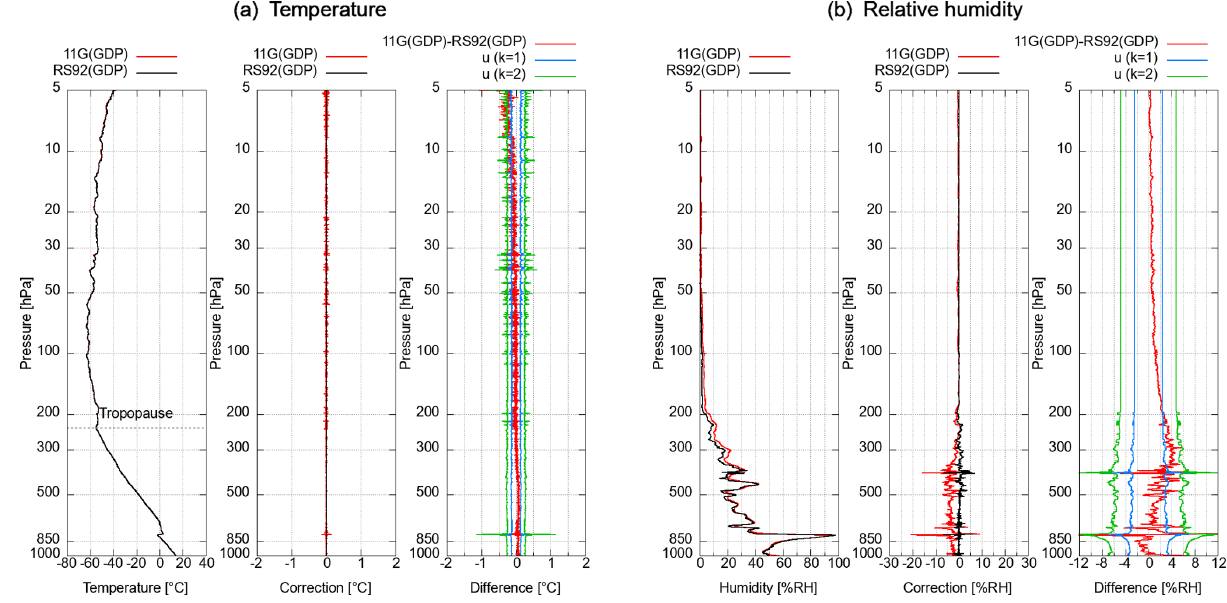
Figure 22. As per Fig. 21 but for the flight launched at 20:30 (LST) on 4 November